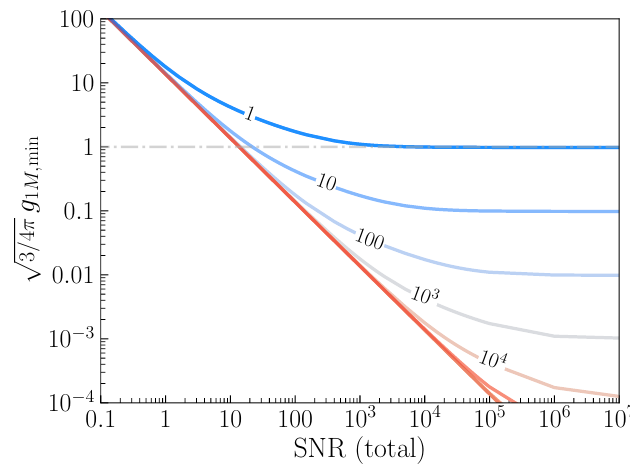
FIG. 4. The smallest detectable dipole coefficient g 1 M, min as a function of the total signal-to-noise for (cid:96) max = 8. The different curves show results obtained for different numbers of statistically independent maps n ω , assuming that the total SNR is distributed equally among all these maps